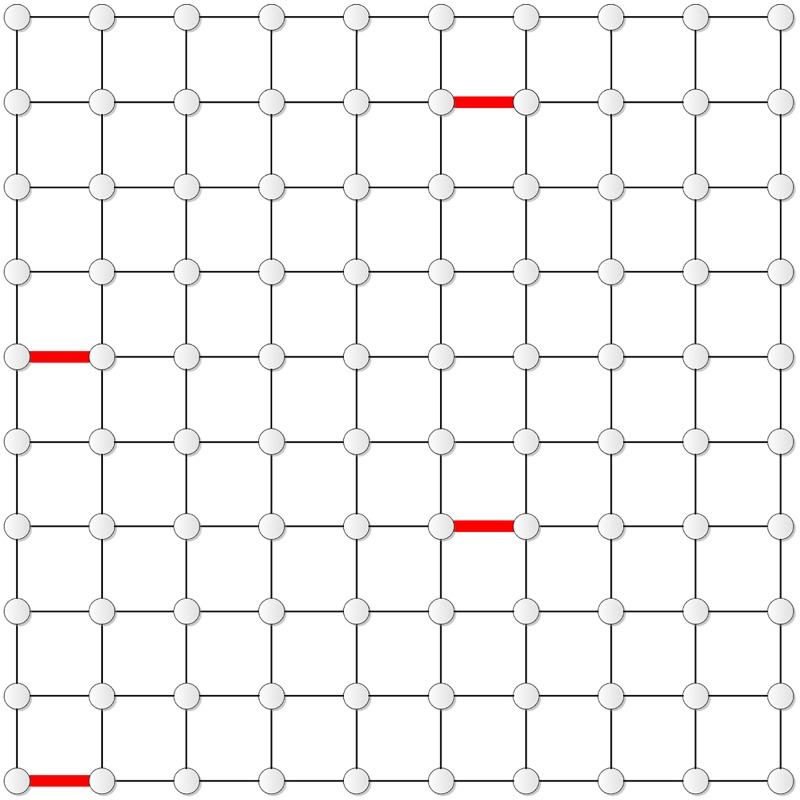
The distribution of the four edges in T10.